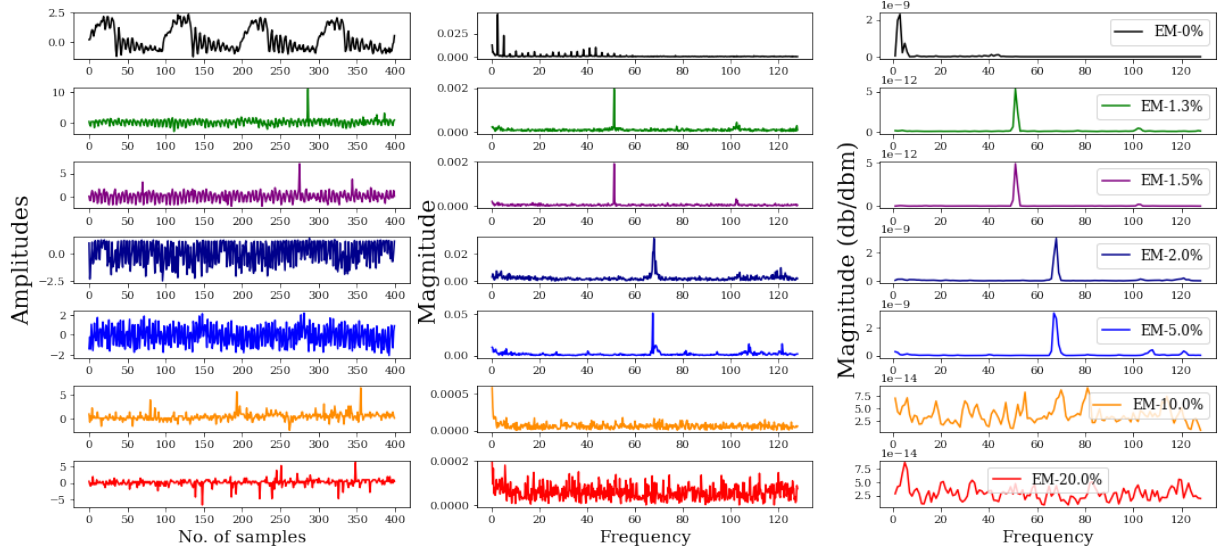
Figure A4. CR signals and their FFT and PSD outputs at 1700 RPM for the emulsion